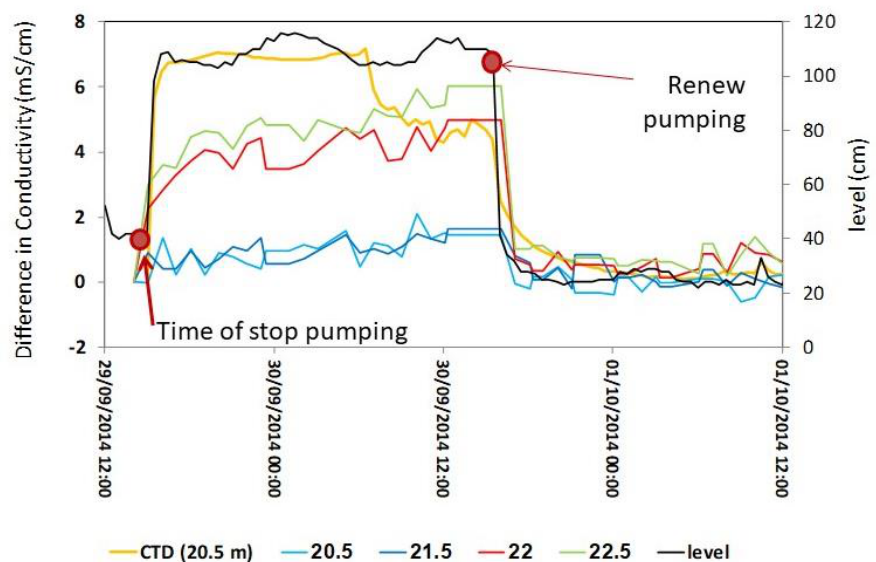
Figure 10. SMD and CTD measurements of the di ff erence in water electrical conductivity in well 71-2 during a pumping break of 24 h in well p211. Also shown is the water level in well 71-2. Measurements by SMD are from several depths with 1-h frequency, while the CTD was located at a depth of 20.5 m with 0.5-h frequency.